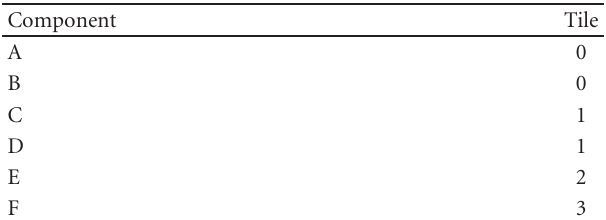
Table 2: Component mapping table for Figure